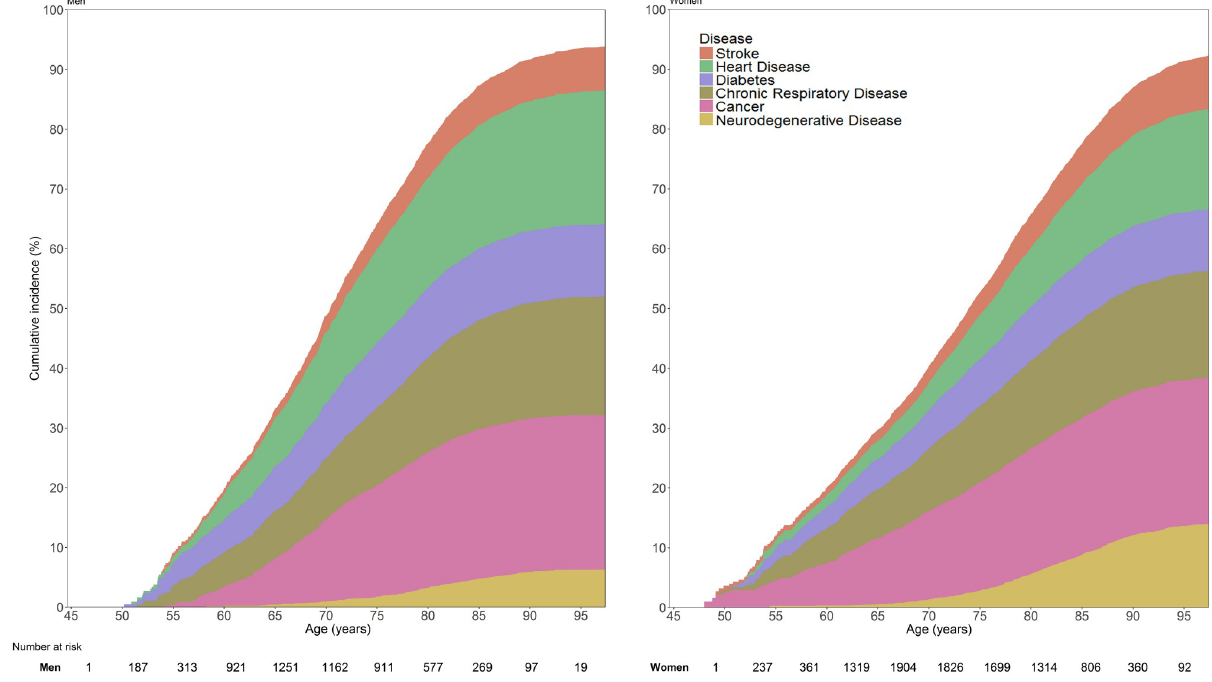
Fig 2. Lifetime risk of NCDs for 45-year-old men and women. In this analysis, follow-up ended at the time of first occurrence of an NCD. For instance, for participants who first experienced heart disease and subsequently developed neurodegenerative disease, only heart disease is considered here. NCD, non-communicable